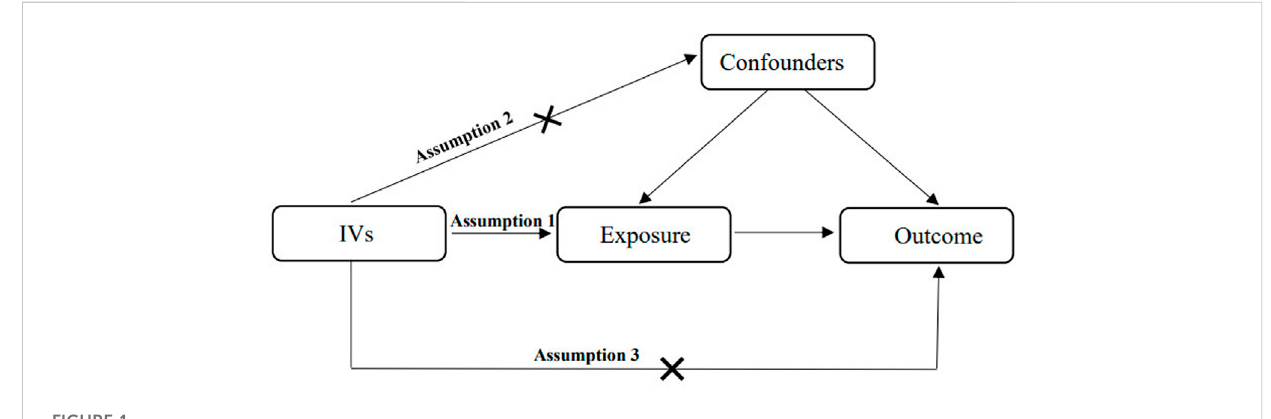
FIGURE 1 The critical assumptions of MR